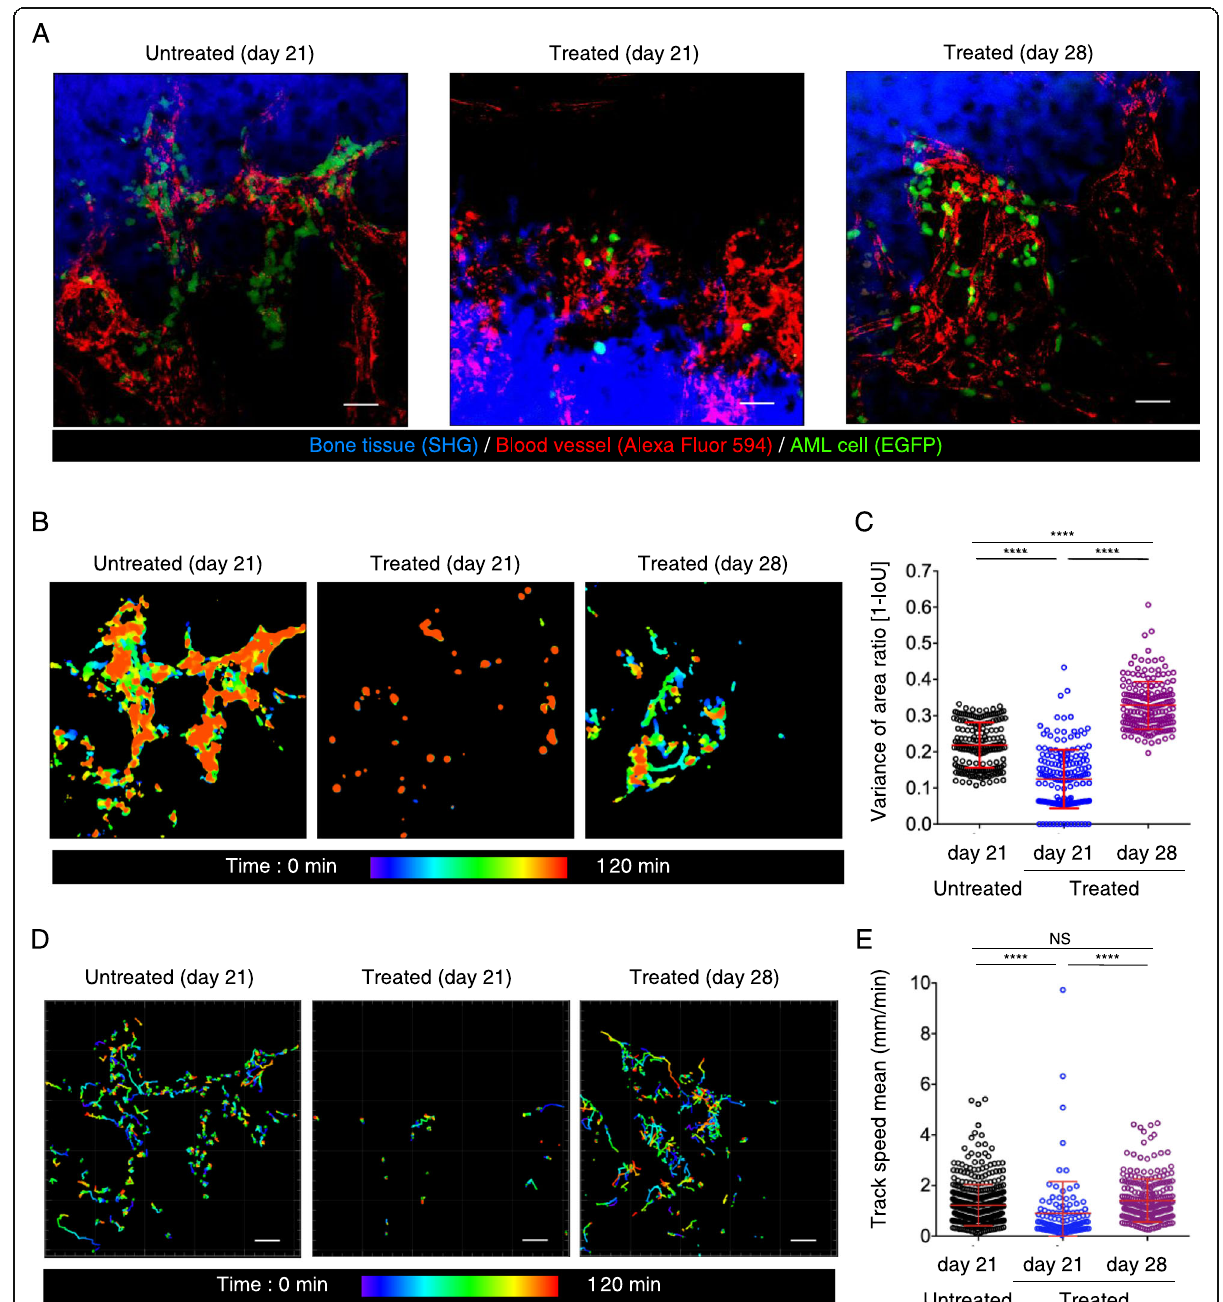
Fig. 1 Dynamics of AML cells in bones during chemotherapy. a Representative intravital two-photon maximum-intensity projection (MIP) skull images at 21 and 28 days after AML cell transplantation. Images from untreated AML-transplanted mice at day 21, treated AML-transplanted mice at day 21 and treated AML-transplanted mice at day 28 are shown. Green, GFP-expressing AML cells; red, blood vessels (Alexa Fluor 594); blue, bone tissues (second harmonic generation; SHG). Scale bar, 50 μ m. See also Video 2. b Representative images showing AML cell area. Scale bar, 50 μ m. c Scatter plots showing displacement area ratio. Data are presented as mean ± SD; n = 3 mice per group; **** P < 0.0001 (one-way ANOVA). d Representative images of migrating AML cell trajectories. Scale bar, 50 μ m. e Scatter plots showing the mean track speed of all cells analyzed in ( d ). Data from three mice per group from independent experiments are shown. Untreated (21 days), n = 461; treated (21 days), n = 108; treated (28 days), n = 243. Data are presented as mean ± SD. **** P < 0.0001; NS, not significant (one-way